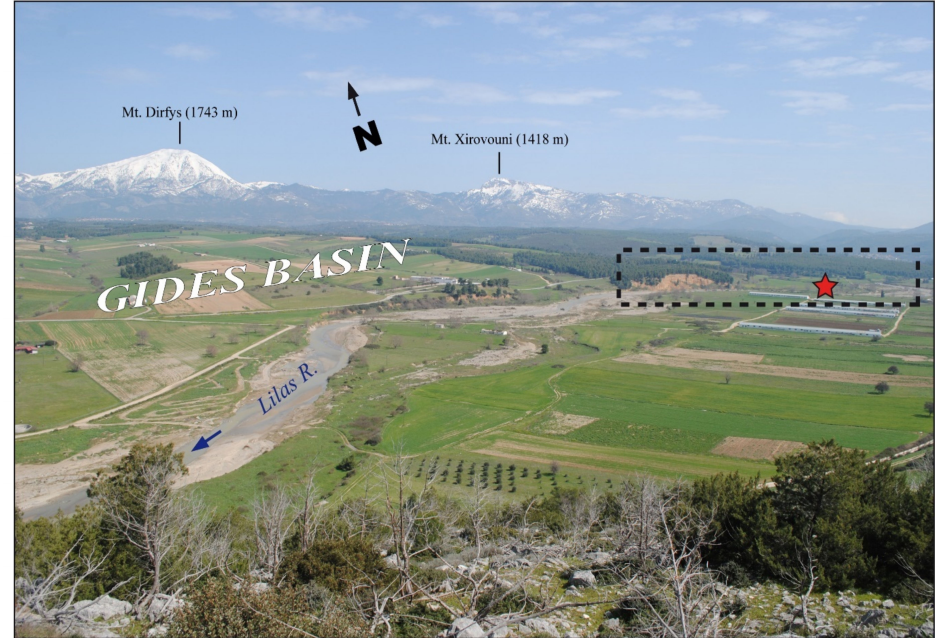
Figure 2. View to the north of the Lilas river in the area of Pissonas, Gides basin (March 2010). The rectangular area limited by a dashed line corresponds to the investigated area; terrace geometry is reported in Figure 3. The red star indicates the location of the studied profile.